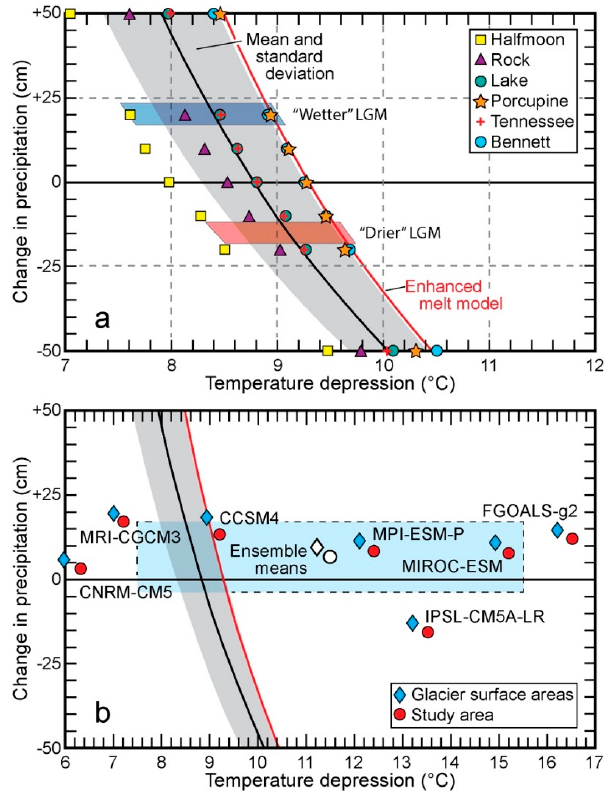
Figure 5. ( a ) Last Glacial Maximum (LGM) temperature depressions required for steady-state mass balance of paleoglaciers given assumed changes in precipitation. ( b ) Panel (a) redrawn to include changes in temperature and precipitation in CHELSA downscaled PMIP3 simulations for the LGM in the study area, and corresponding changes over glacier areas only (both areas shown in Figures 6 and 7). Blue shaded box shows standard deviation of ensemble means for the study area only. See text for Table 5. Sensitivity of TM simulations to variations of parameter values and resulting uncertainties, 368 grouped by whether the variation increases (positive values) or decreases (negative values) the 369 temperature depression required to maintain steady-state mass balances of paleoglaciers. 370